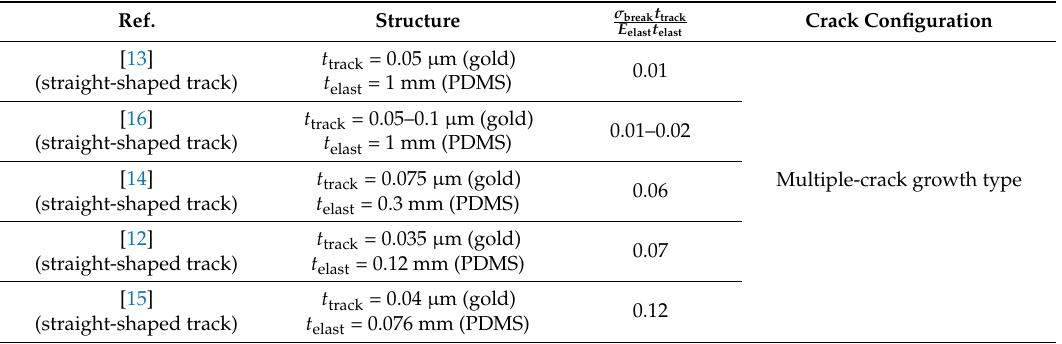
Table 1. Relationship between the calculated values of the ratio of the elongation stiffness and the crack configurations, in previous studies and this